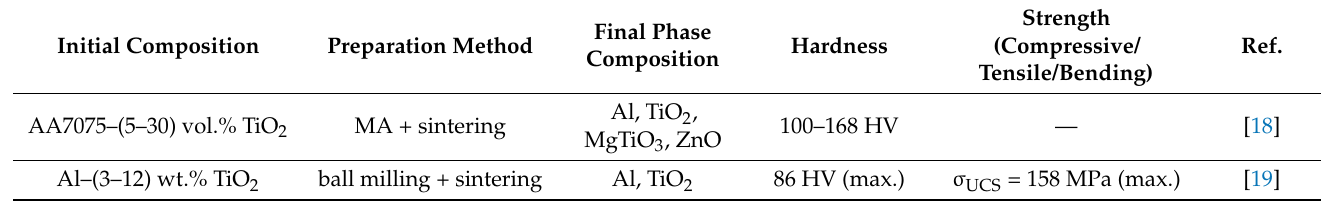
Table 1. Composition, preparation methods, and mechanical properties of Al-TiO 2 composites obtained in other